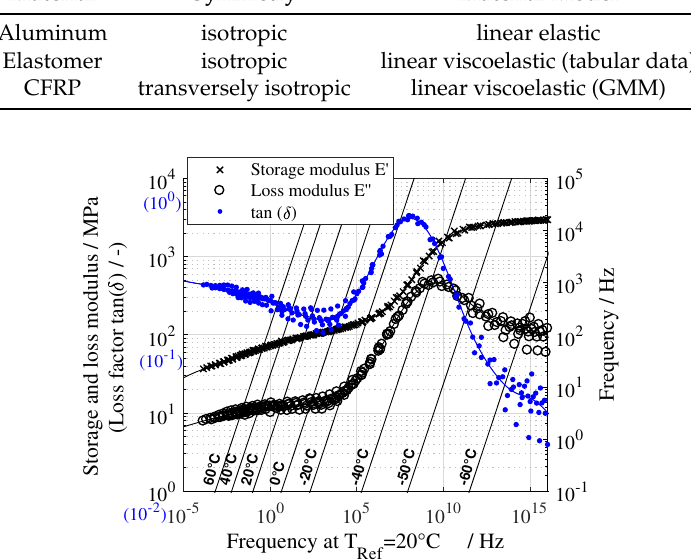
) . ,El s ,El s .05 .5 .65